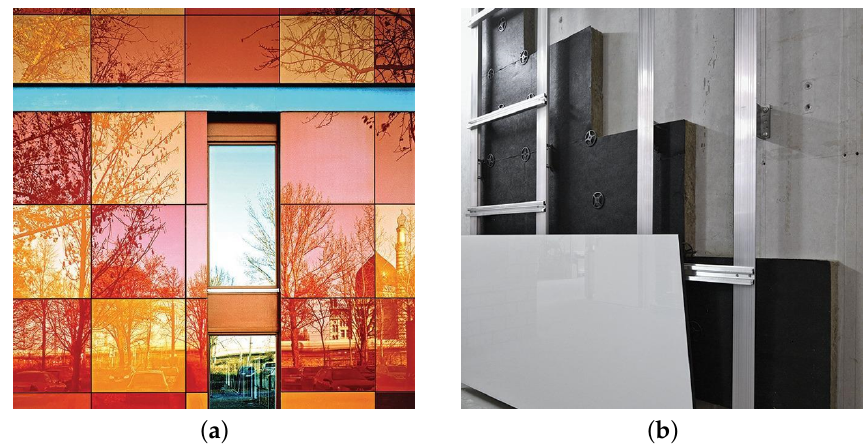
Figure 2. Rainscreen wall system: Glass cladding installed on the outside of a building ( a ) and a rainscreen cladding sub-construction ( b )